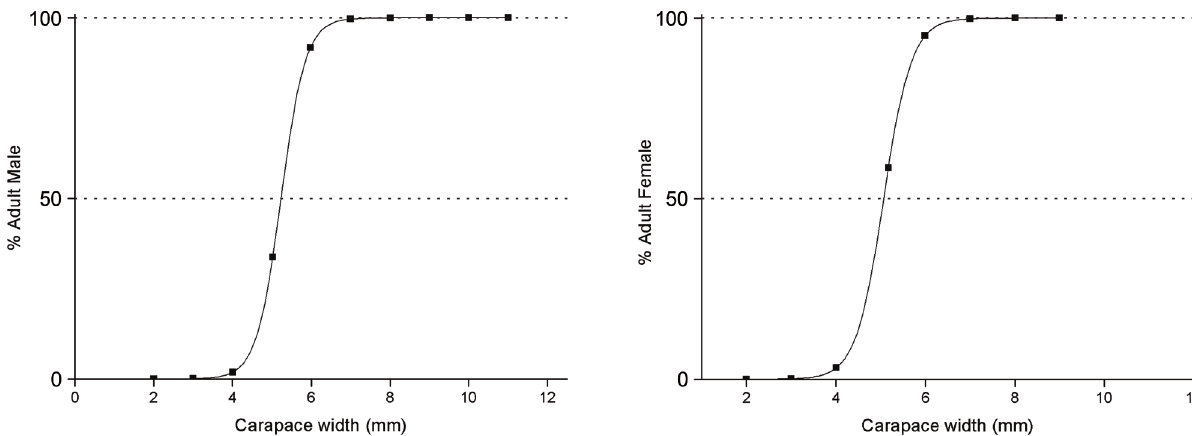
Figure 7. Adjustment of the logistic function, indicating carapace width (CW) of Panopeus austrobesus , where 50% of the crabs are morphologically mature, in the mussel farm at Itaguá Beach, Ubatuba, State of São Paulo, Brazil.